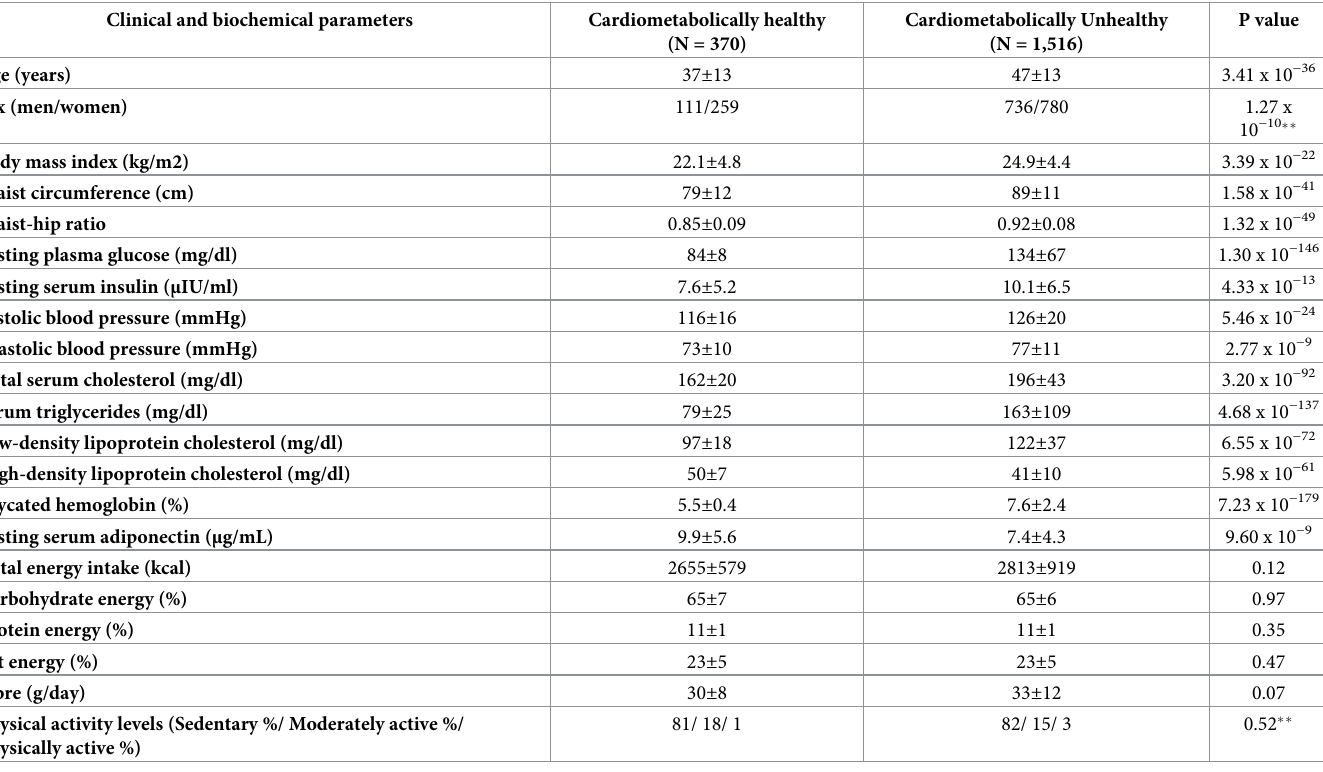
Table 1. Clinical and biochemical characteristics of the participants from the CURES study. Clinical and biochemical parameters Cardiometabolically healthy